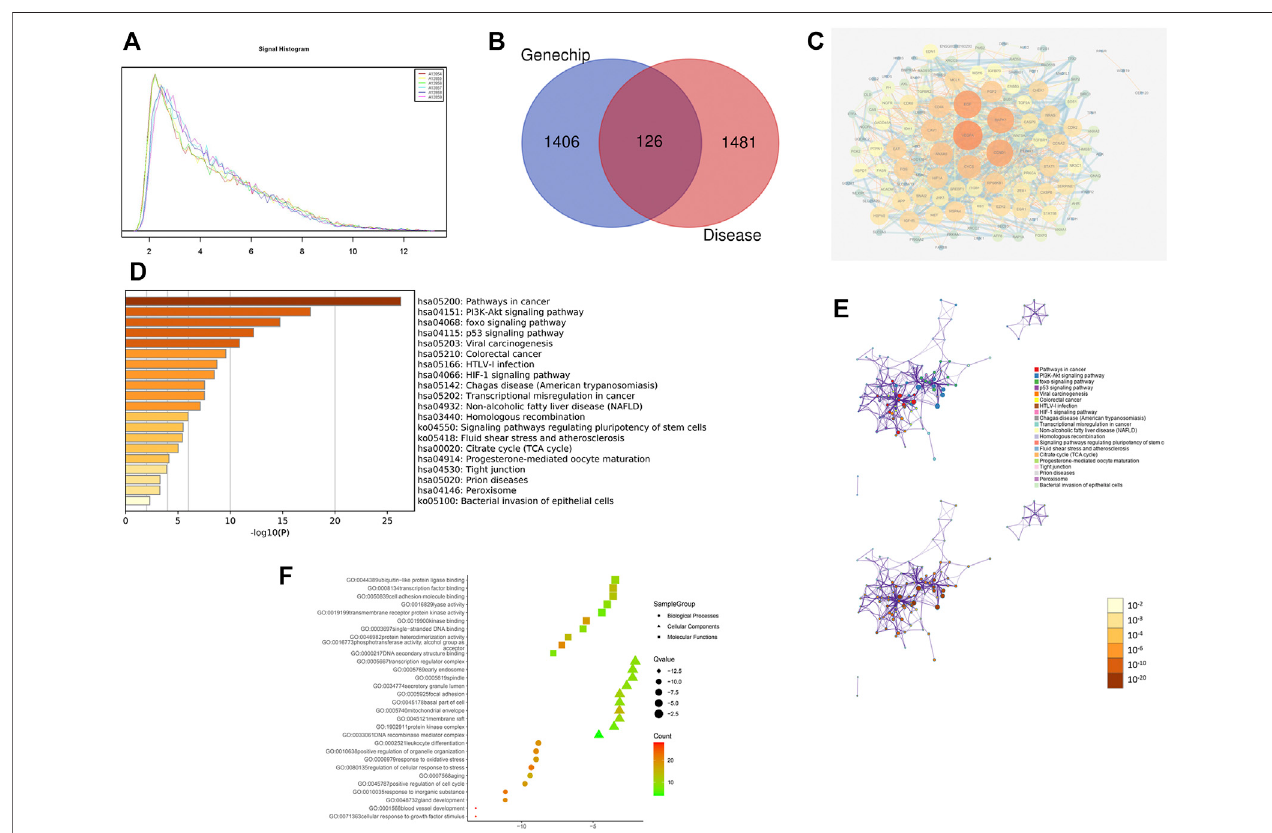
FIGURE4| GenechipmodelofZZXJT.Notes: (A) :Statisticalplotofsignalintensitydistributionbetweennormalandmedicationgroups. (B) :IntersectionofZZXJT predicted targets and HCC targets. (C) : PPI network of intersection target action relationship. (D) : Main pathways in the gene chip model. (E) : Distribution and signi fi cance of target proteins in pathway (D) . (F) : The further prediction and analysis of the target ’ BP, CC, and MF.